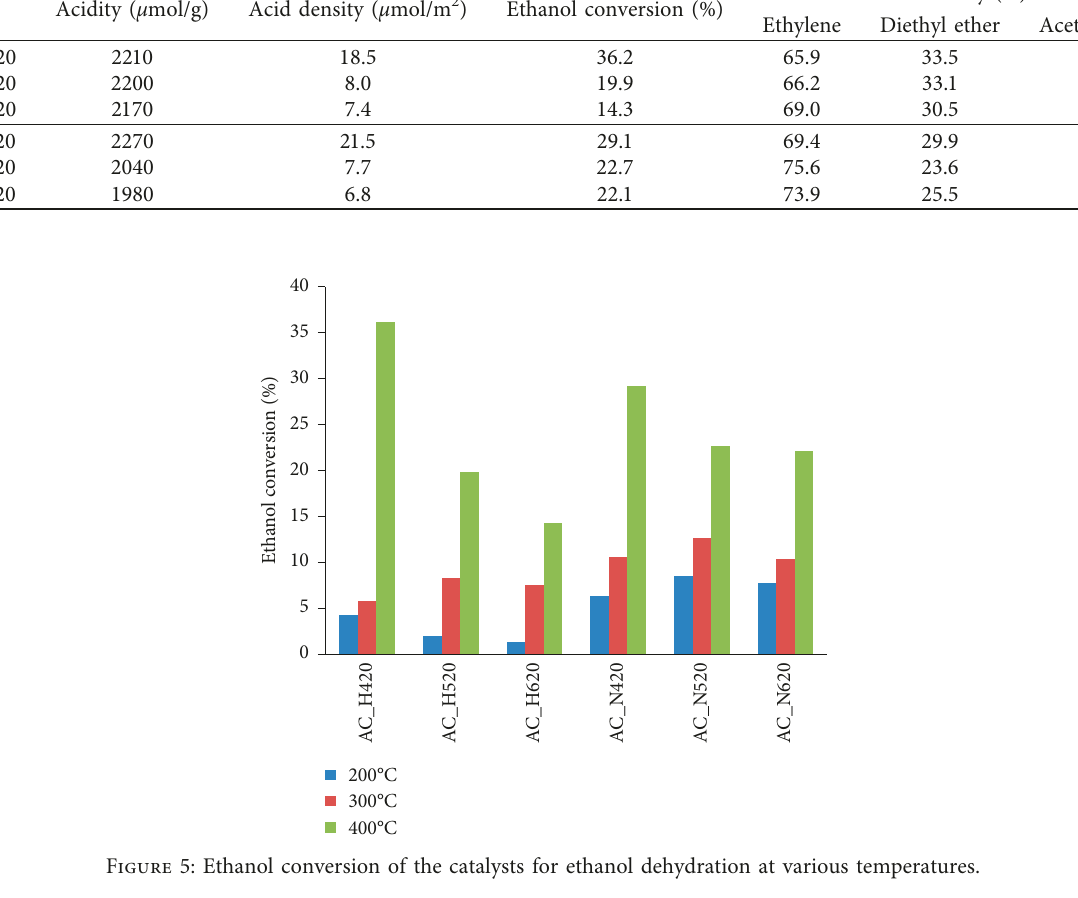
Table 3: Surface acidity, total conversion, and product selectivity of carbon-based catalysts at 400 ° C. Sample